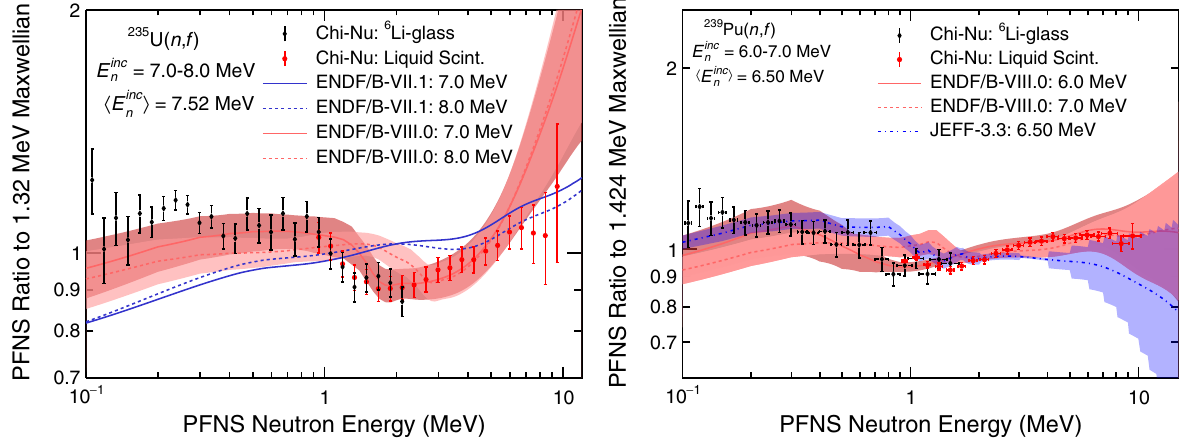
Figure 2. Second-chance fission PFNS features observed by the Chi-Nu experiment for neutron-induced fission of 235 U (left) and 239 Pu (right) are shown here. The experimental incident neutron-energy ranges are shown in each plot. The bands and trends correspond to evaluations at relevant incident neutron energies